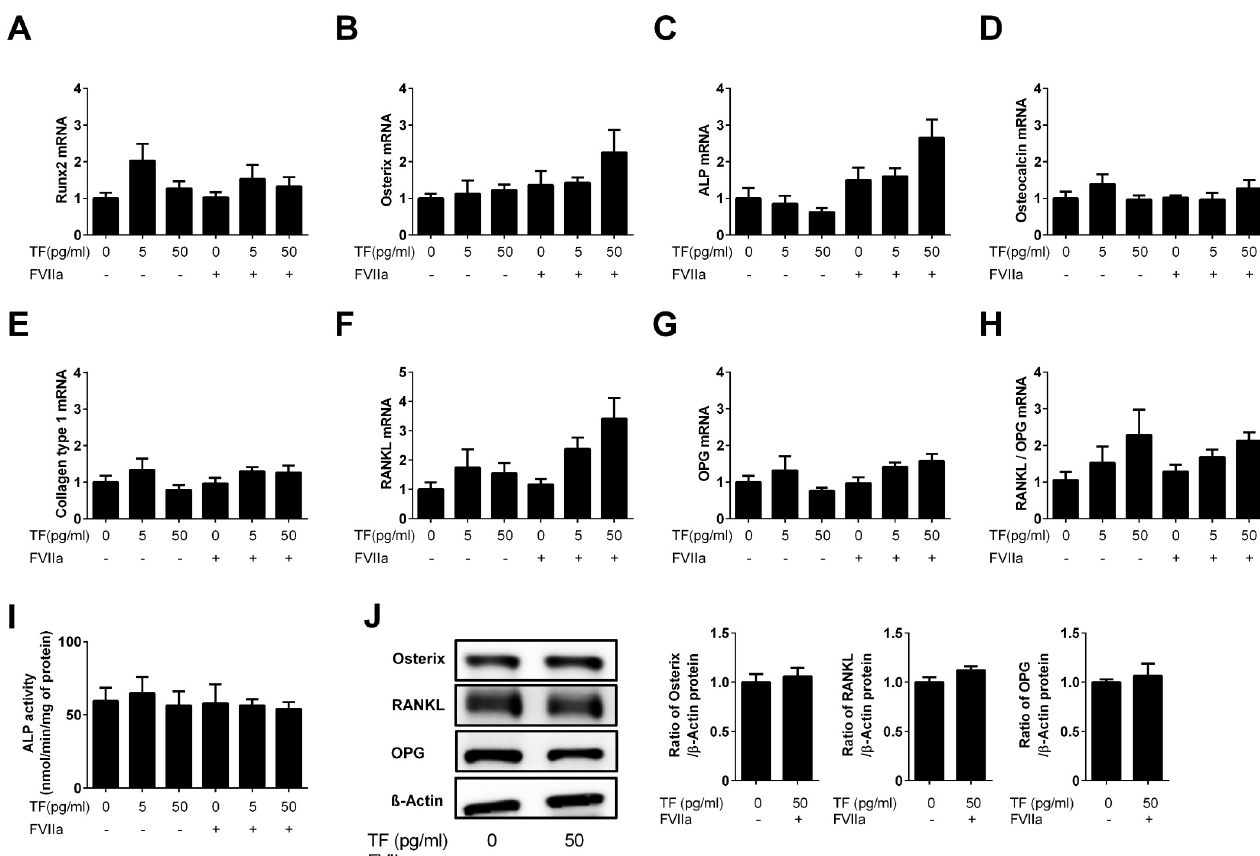
Fig 5. Effects of TF on the osteoblast phenotype. Mouse primary osteoblasts were isolated from the neonatal calvariae of 3- to 6-day-old WT mice, and osteogenic and osteoblast-related gene expression levels in the presence or absence of the indicated concentrations of TF with or without FVIIa (8 pg/mL) were quantified by qPCR. The mRNA levels of Runx2 (A), osterix (B), ALP (C), osteocalcin (D), type 1 collagen (E), RANKL (F), and OPG (G) and the RANKL/ OPG ratio (H) were analyzed and normalized to GAPDH mRNA levels. ALP activity levels in cell homogenates were also quantified (I). Data represent the mean ± SEM of 6 experiments in each group. (J) Total protein was extracted from mouse osteoblasts treated with or without TF (50 pg/mL) and FVIIa (8 pg/ mL). A Western blot analysis of osterix, RANKL, OPG, and β -actin was then performed. Images represent experiments performed independently in triplicate. Protein signals were quantified by densitometry and adjusted by the density of β -actin. Data represent the mean ± SEM of 3 experiments in each